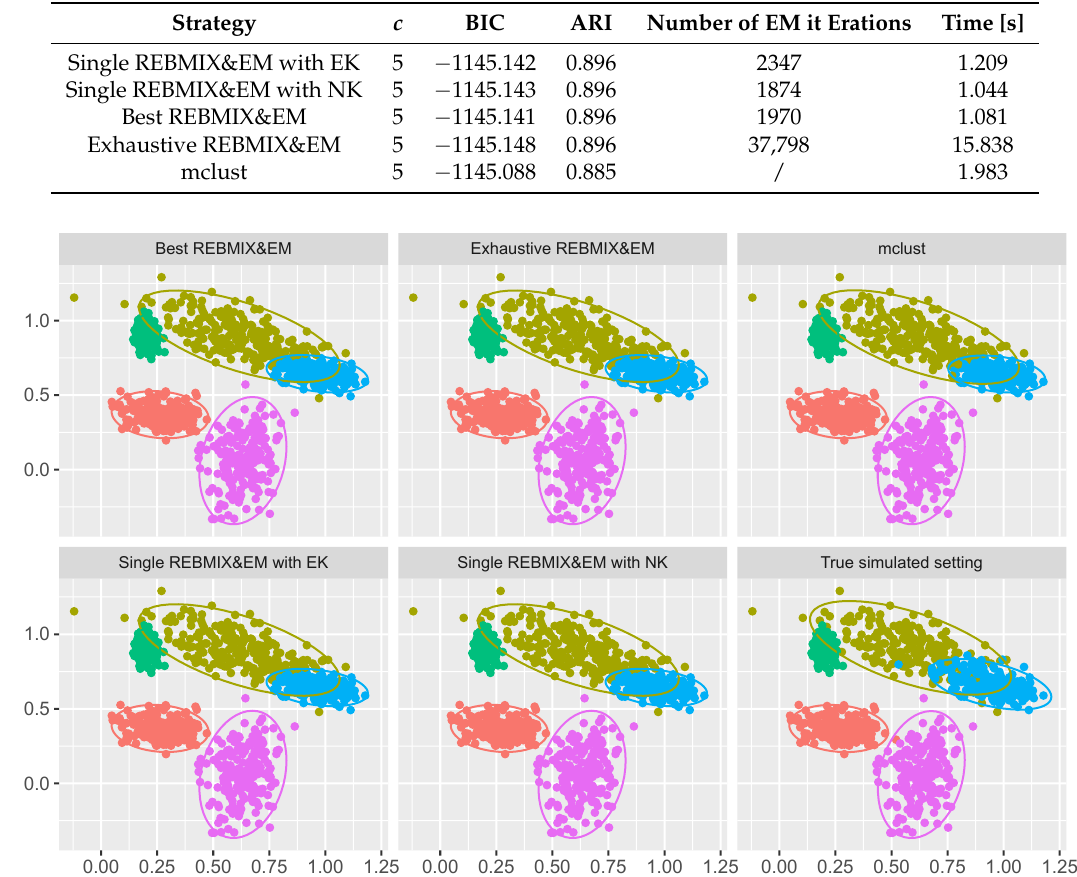
Figure 5. Solutions obtained from different methods used and the true clustering solution on the low overlapping clustering